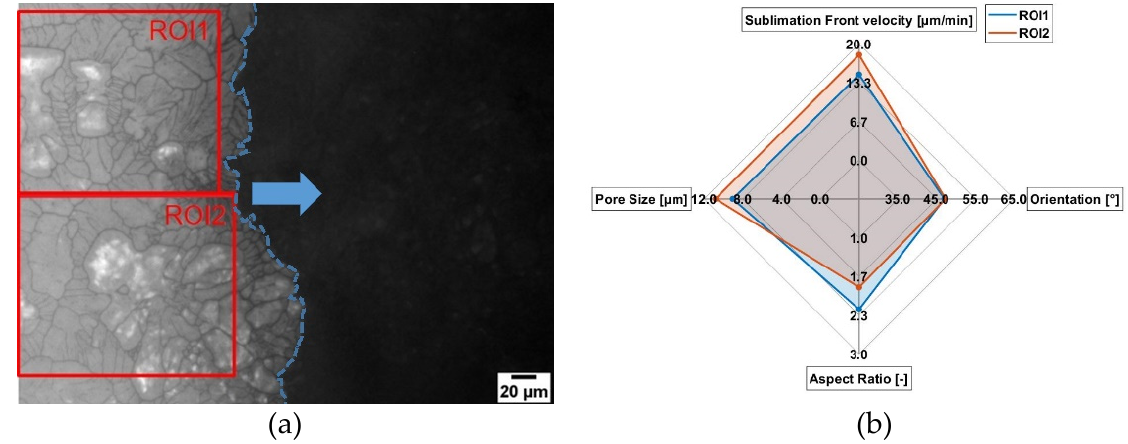
Figure 9. Influence of the microstructure on the local sublimation front velocity for maltodextrin (c = 0.05 w/w, 1 K/min cooling rate). ( a ) Lyomicroscope Image and ( b ) Results.